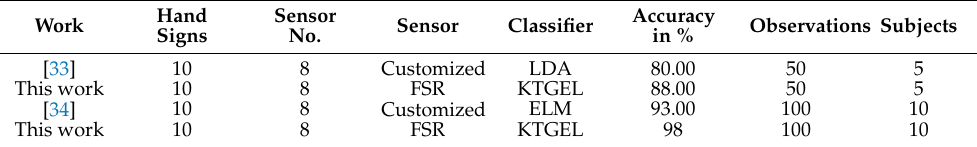
Table 3. Performance of the proposed classifiers vs. the state of the art of ASL numbers’ recognition by